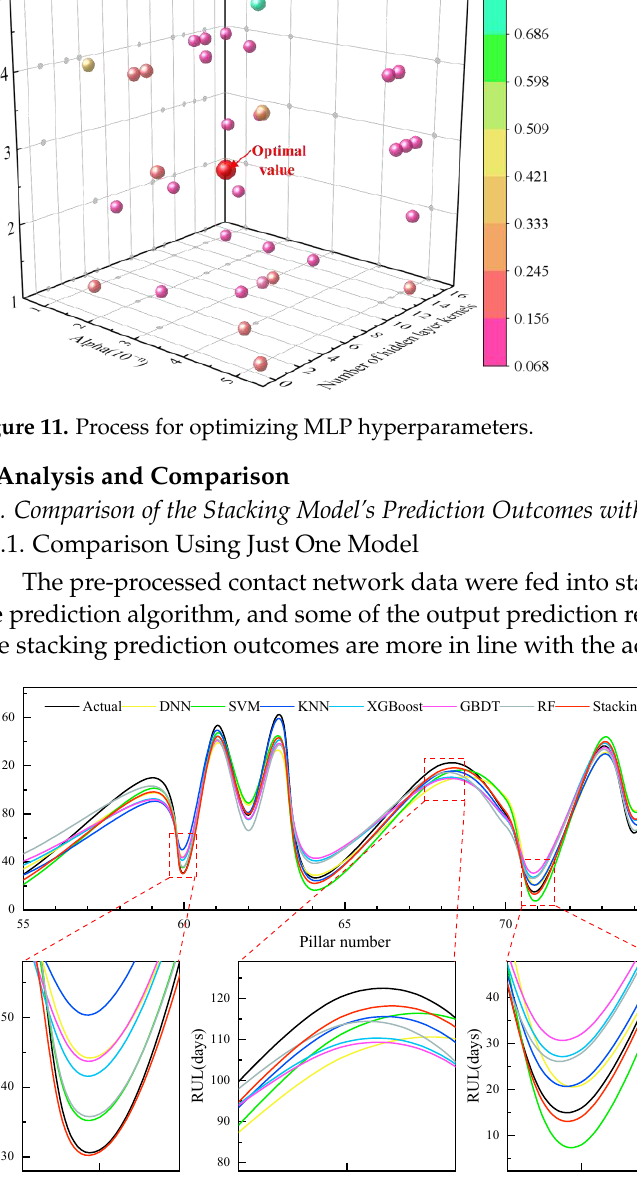
Figure 12. Comparison of predicted and actual values for DNN, SVM, KNN, XGBoost, GBDT, RF and stacking.